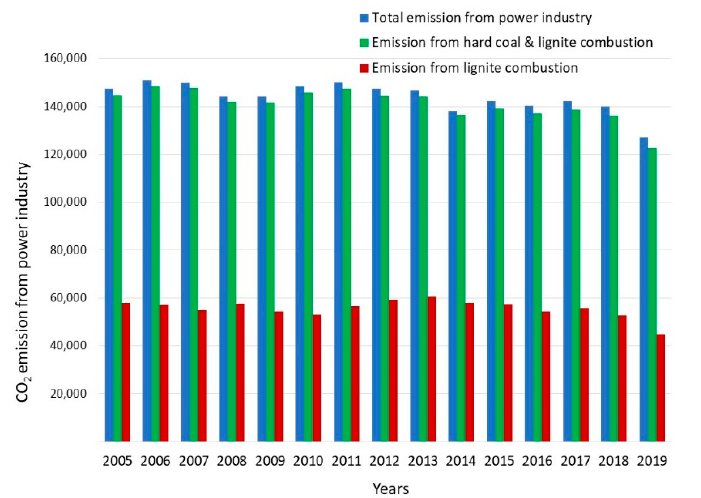
Figure 1. CO 2 emissions from the power industry, kt, between the years of 2005 and 2019 (based on the data from [3]).